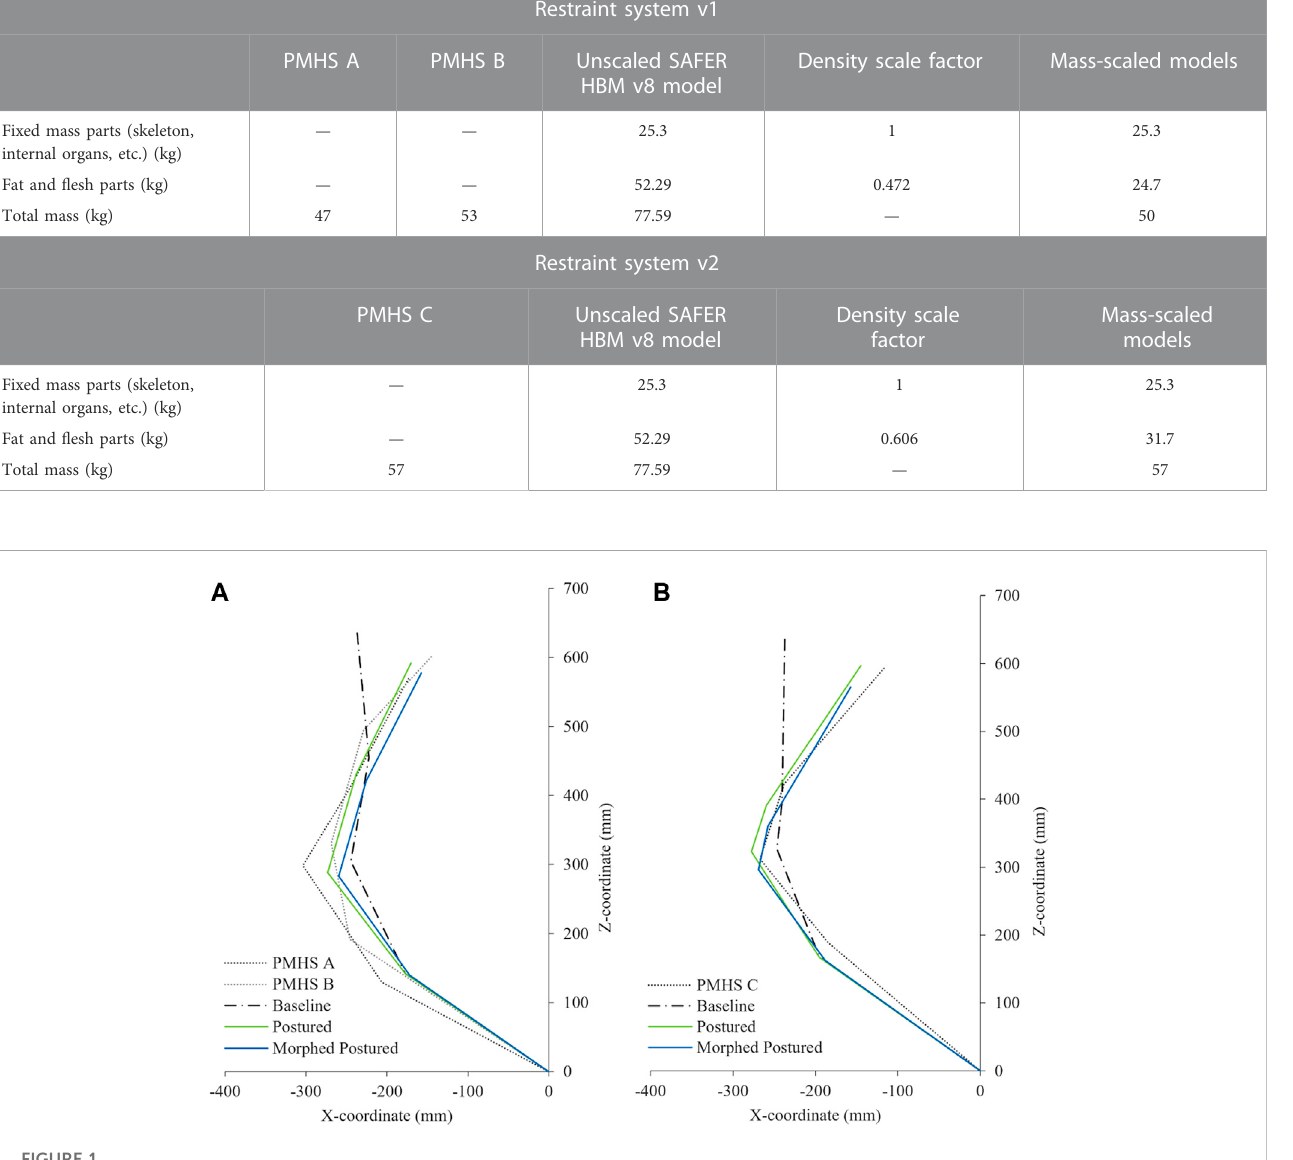
Spine alignment representation at t = 0 ms of the PMHS, THUMS baseline model, and postured models. (A) RSv1 and (B)